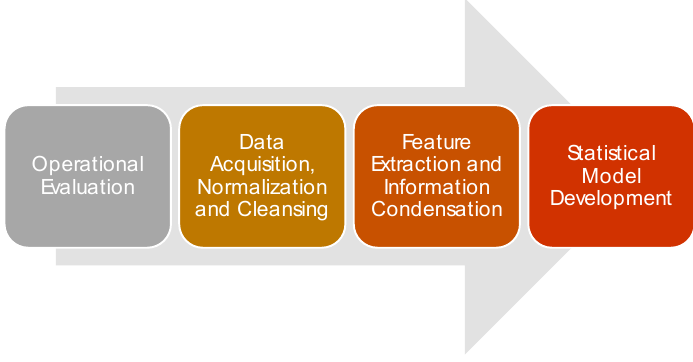
Figure 1. Statistical Pattern Recognition stages.